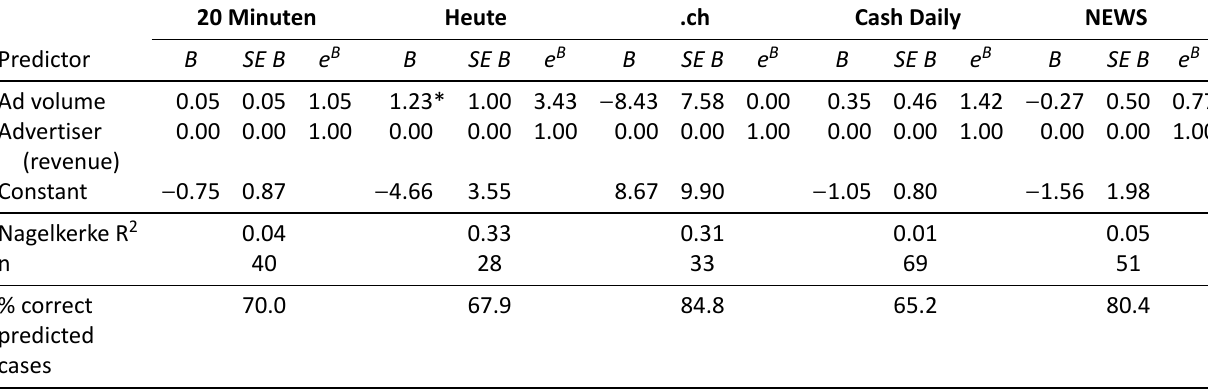
Table 6. Individual model with regard to journalists’ and quoted evaluations. 20 Minuten Heute .ch Cash Daily